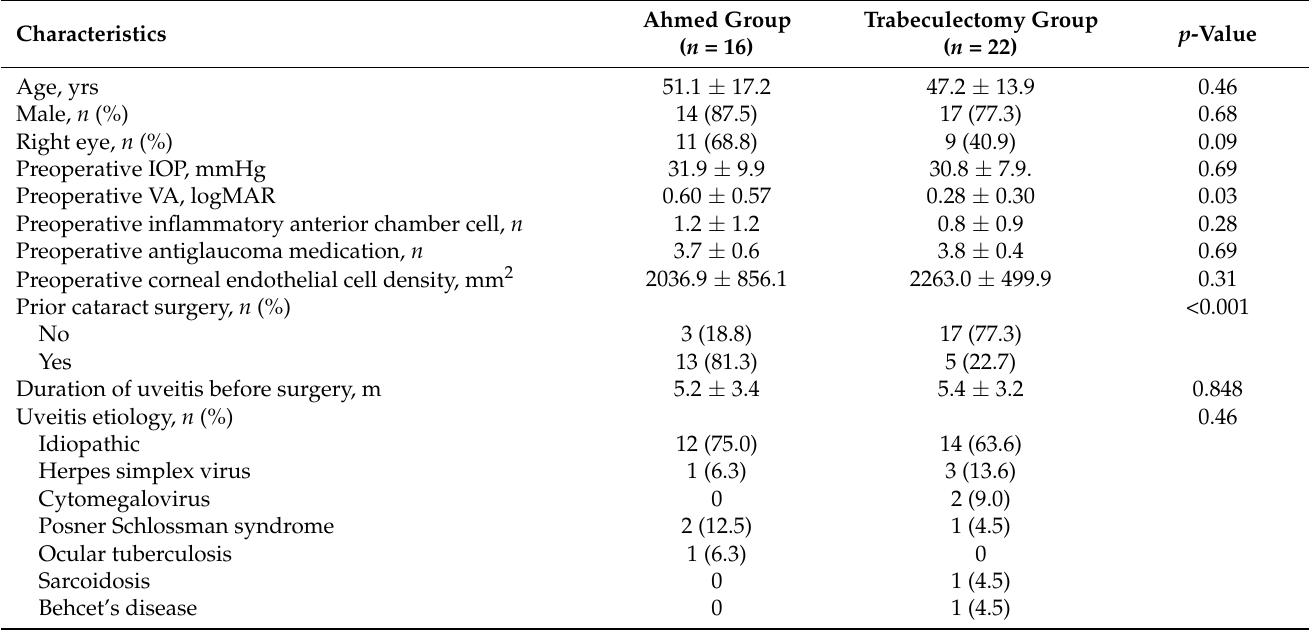
Table 1. Baseline characteristics of Ahmed group versus trabeculectomy